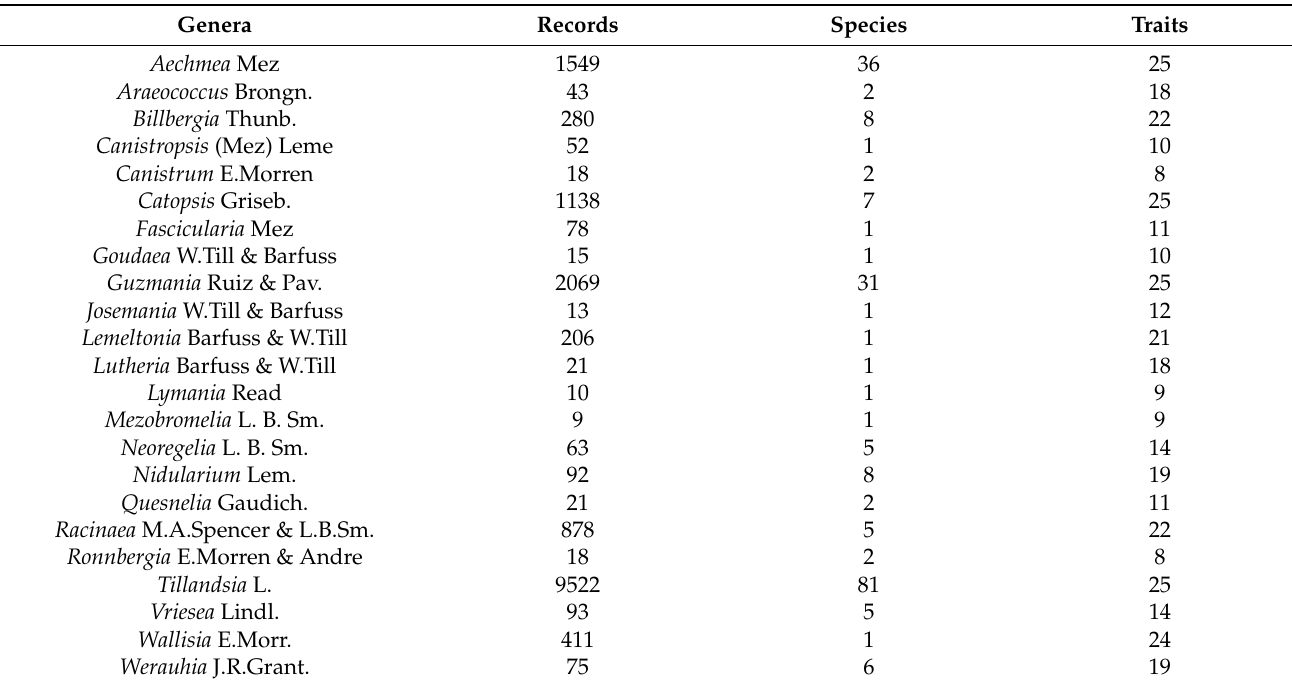
Table 2. Trait representation across genera of the Bromeliaceae